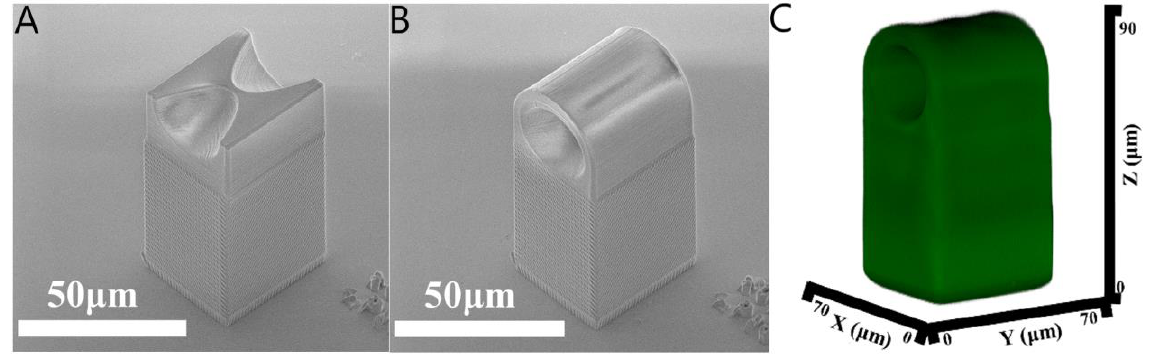
Figure 14. Aspherical lenses for X-rays. ( A ) SEM image of the cut structure. ( B ) SEM image of the structure. ( C ) CLSM image.